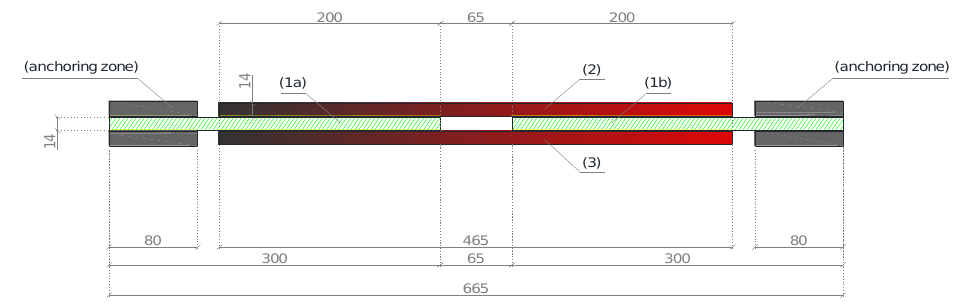
Figure 2. Joint configuration (side view).